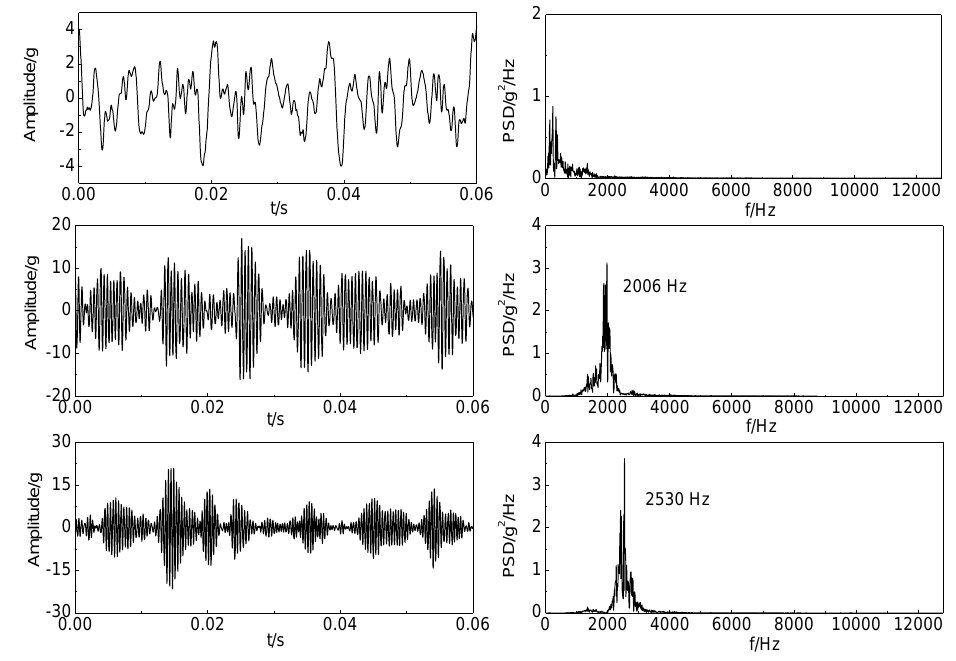
Figure 12. The VMD result of valve increase (0.40, 0.60).